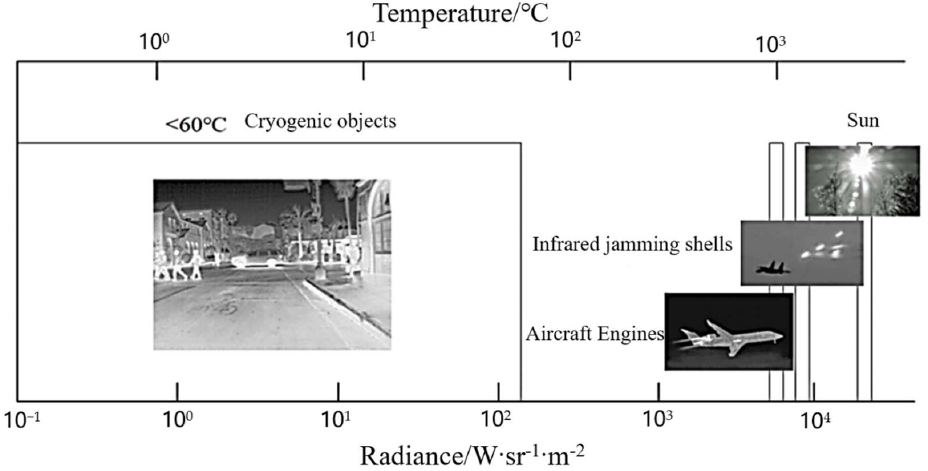
Figure 3. Radiance distribution of typical objects at different temperatures in the LWIR band. Region-growing point segmentation [32] is a traditional algorithm that can be ap- plied in infrared imaging. The basic method is to define the seed point and decision rules and add neighboring pixels with similar properties to the seed. The aim is to form the corresponding growth region. Analyzing the scene characteristics of HDR IR images, the